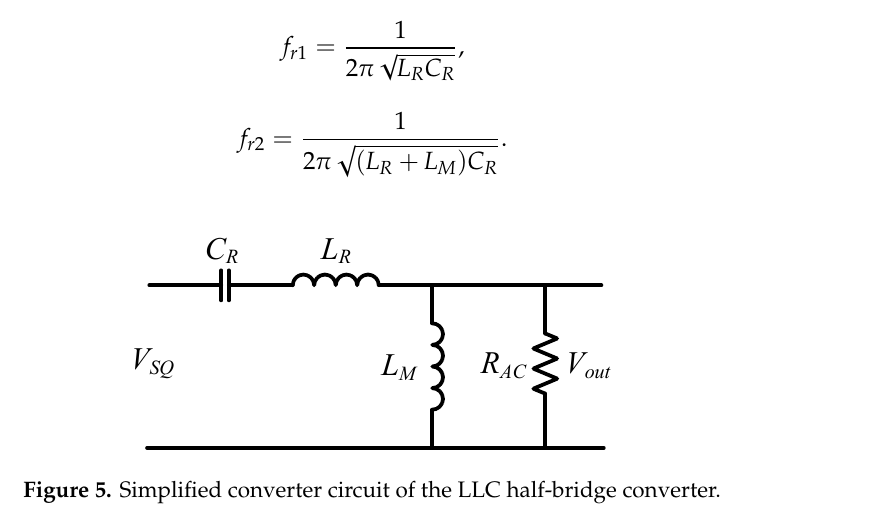
Figure 4. Half-bridge LLC resonant converter topology. Figure 4. Half ‐ bridge LLC resonant converter topology.